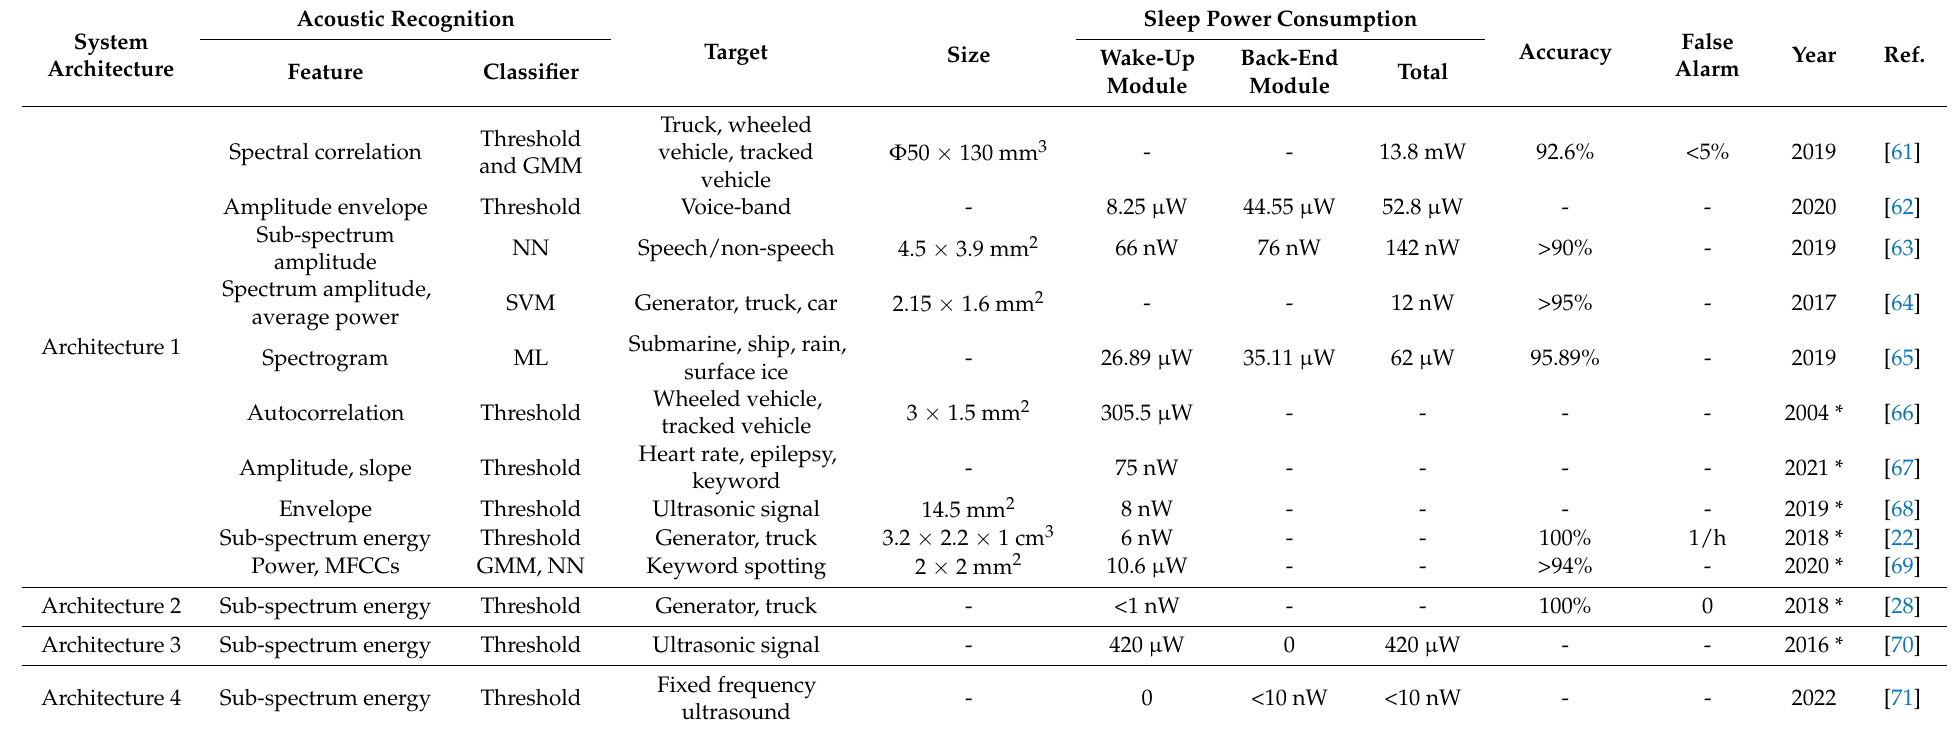
Table 3. Acoustic wake-up